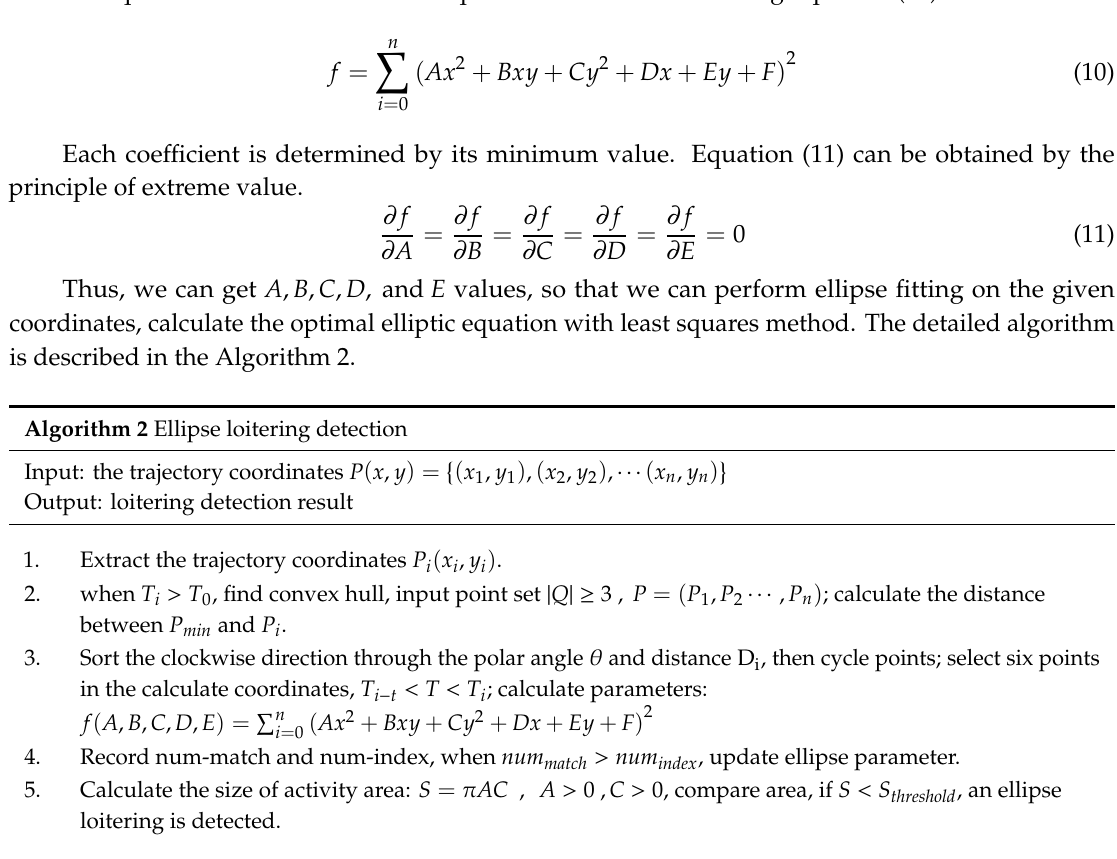
Figure 8. Finding a convex hull of a set of points.